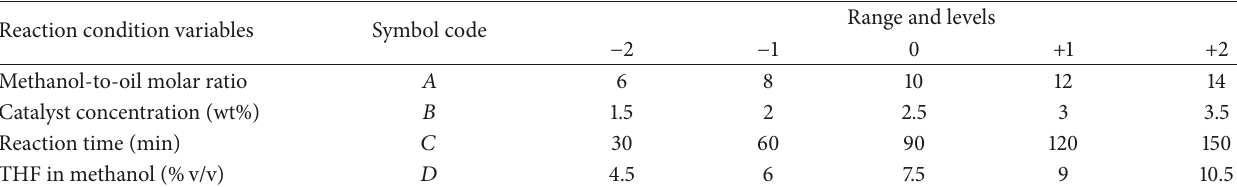
Table 1: Reaction condition variables and levels for CCD.